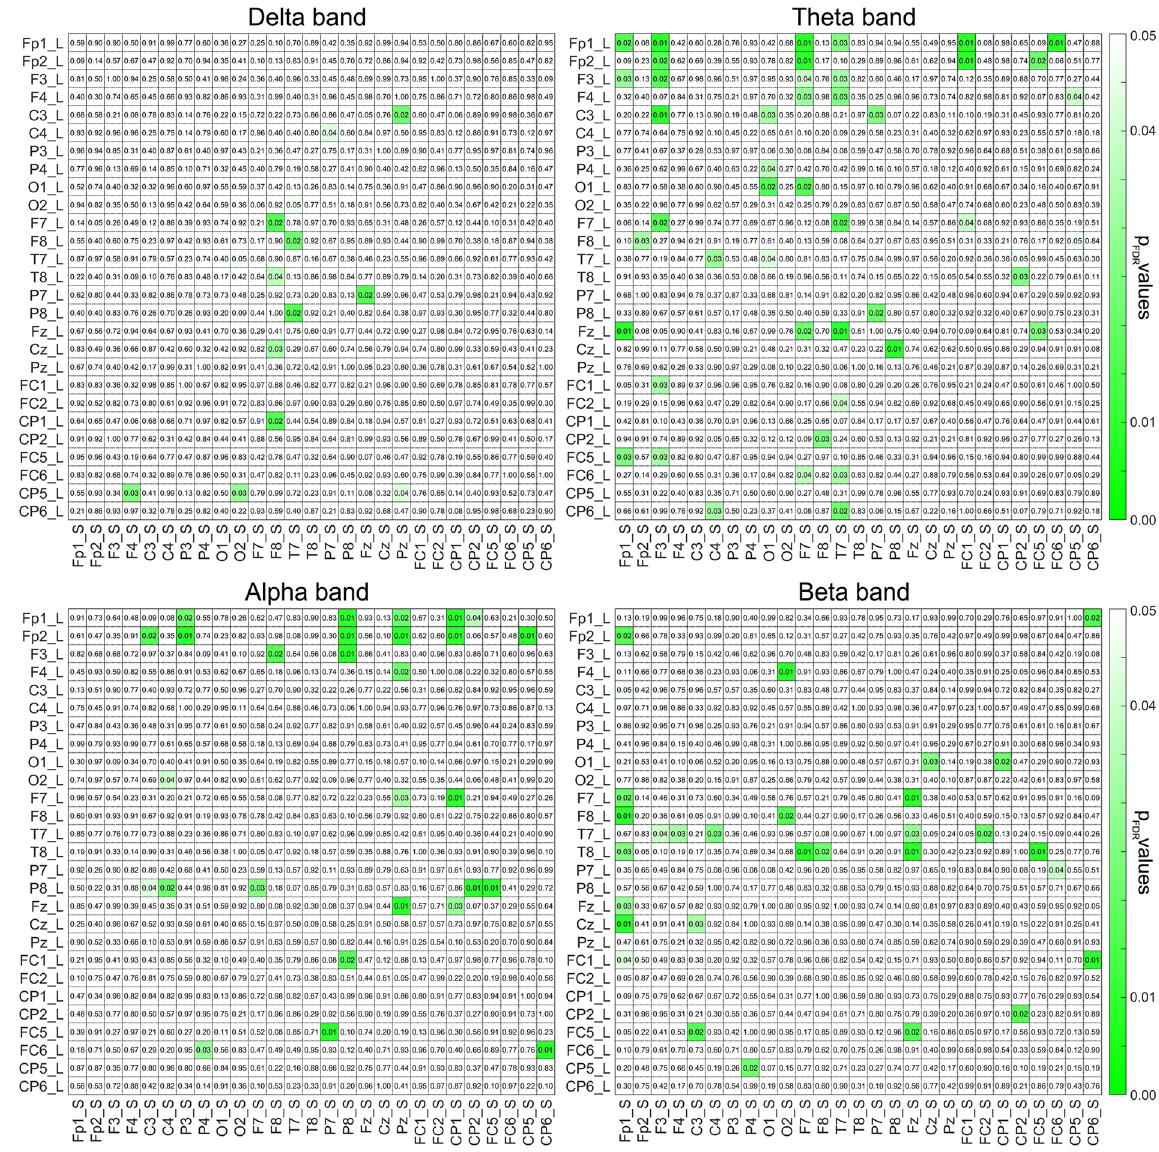
Figure 1. Group-level statistical results from the brain-to-brain synchronization analysis at the different frequency bands. The matrices contain the FDR-corrected p values from nonparametric permutation tests (rounded) between each channel of the Listener and each channel of the Speaker. Statistically significant coupling (PLV) between listeners and speakers during oral narratives is indicated by coloring in green the corresponding cells with p FDR < 0.05. Rows represent the electrodes of the Listener and columns the electrodes of the Speaker. Significant interbrain synchronization, as compared to the surrogate dataset, is evident with different topographical patterns for delta, theta, alpha and beta frequency